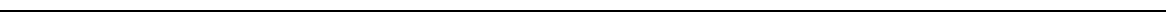
Fig. 2 Nuclear ploidy and binucleation: zone-speci fi c distribution and its developmental change detected by double staining immunohistochemistry with cell membrane marker β -Catenin and nuclear marker Hoechst-33342. By applying the immunohistochemistry of β -Catenin, we analyzed the nuclear ploidy and multinucleation in WT ( a, c ) and Per -null ( b, d ) mice (10 weeks). ( c ) and ( d ) are high-power fi eld photomicrographs of indicated areas of ( a ) and ( b ), respectively. We divide the liver lobule in 15 zones, as indicated by the lines, and counted the mononuclear 2n cells (2n × 1), binuclear 2n cells (2n × 2), mononuclear 4n cells (4n × 1), binuclear 4n cells (4n × 2), mononuclear 8n cells (8n × 1), binuclear 8n cells (8n × 2), mononuclear 16n cells (16n × 1), binuclear 16n cells (16n × 2), mononuclear 32n cells (32n × 1) and binuclear 32n cells (32n × 2) according to the nuclear size of 2n cells in each section. e We show the incidence (%) of each ploidy state, mononucleated and binucleated, in each zone (centrilobular, midlobular and periportal zone) for each hepatic lobe ( n = 600 hepatocytes from 5 mice of each genotype), assuming the contribution of each zone to be equal. For developmental analysis f , we analyzed liver from 2, 4, 6, and 8 weeks old WT and Per -null mice ( n = 150 – 360 hepatocytes form 3 – 5 mice of each genotype at each developmental stage), and analyzed the incidence of each polyploidy state, of mononuclear and binuclear cells, in each developmental stage. Data are analyzed by Two- way ANOVA with Bonferroni ’ s post-test. All values represent the mean ± SEM. * P < 0.05, ** P < 0.01, *** P < 0.001. Scale bars, 100 μ m in ( a, b, f ) and 20 μ m in ( c, d ). Note hepatocytes increase their polyploidization progressively age-dependently, except for periportal cells, and the prominent polyploidization and binucleation progressively accelerates in pericentral and midlobular